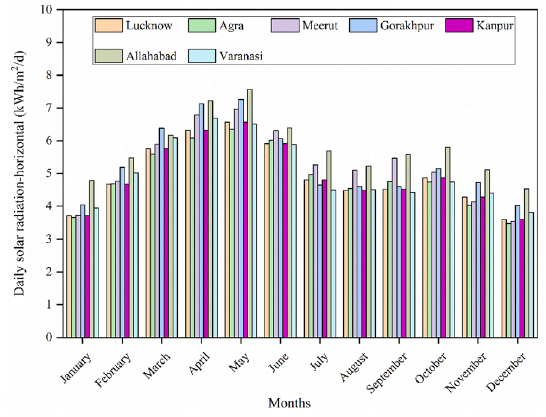
Figure 4. Monthly variation of solar radiation-horizontal.